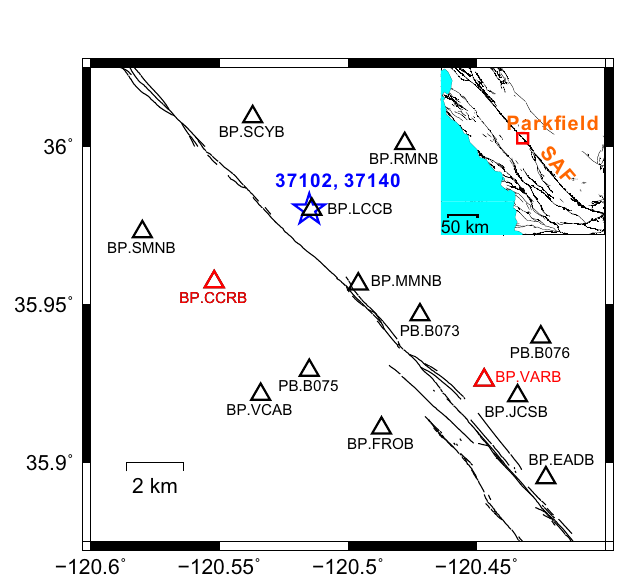
Fig. 1 | Previous slow-earthquake source observations and hypothesis of various-duration low frequency earthquakes. a Previous observations of moment and duration of slow earthquakes (colored circles) at a wide range of sizes 14,16,17,31,33,51 – 53,56 – 59 . LFE low-frequency earthquake, VLFE very low-frequency earthquake, RTR rapid tremor reversal, SSE slow slip event. b Theoretical Brune- type 55 velocity spectral power for LFEs assuming a linear moment-duration scaling and a high-frequency spectral fall-off rate γ of 2 (see Methods). Note that this